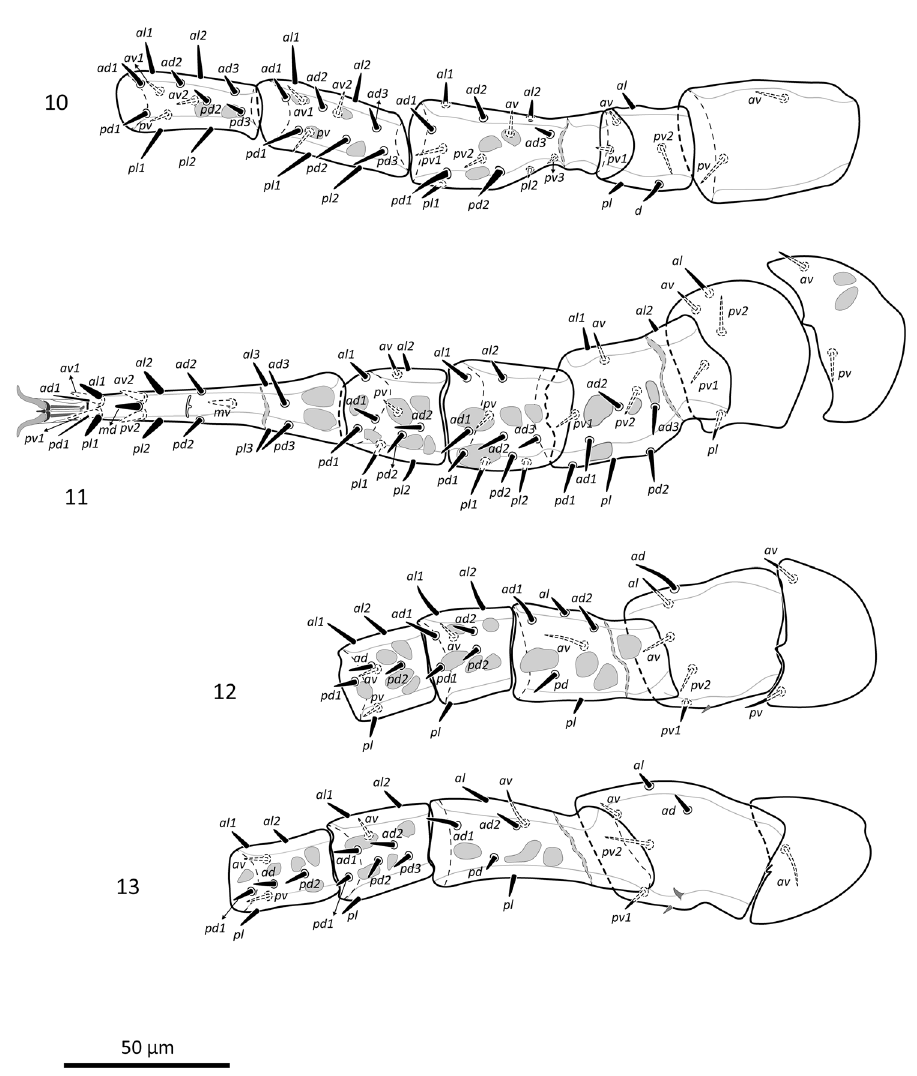
Figures 10–13. Zygoseius papaver sp. n., female, legs I–IV, dorsal view. able for study (broken off specimen). Palp 98 long, similar to that of female; trochanter 13 long, femur 40, genu 22, tibia about 21; palp setae and chaetotaxy as in female. Legs. Lengths of legs: I 288, II 239, III 231, IV 288. Lengths of femora: I 61, II 44, III 55, IV 60; genua: I 45, II 37, III 26, IV 30; tibiae: I 44, II 32, III 25, IV 31; tarsi: I 61, II 71, III 68, IV 87, ambulacra: I 18, II 20, III 19, IV 24. Chaetotaxy of legs I–IV similar to that of female, except that the femur II has one conical spine-like projection ventrodistally (Fig. 14). Setae pd1 – 2 on femur I thickened as in female, pd1 14–15, pd2 10–12. Sigillae locations similar to those of